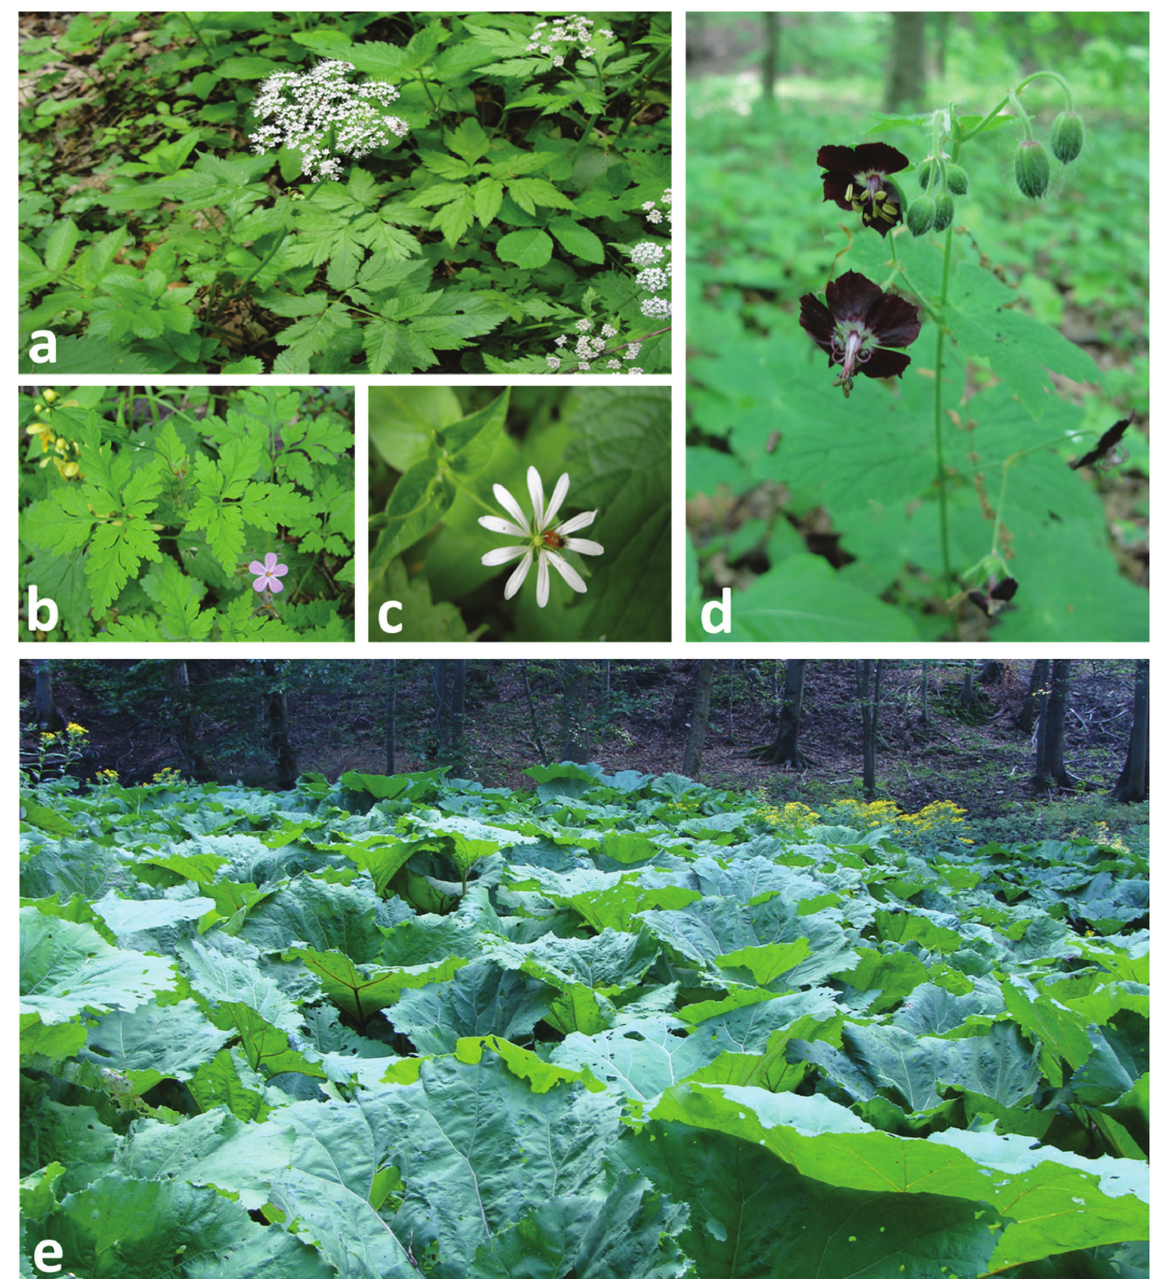
Figure 3. Tall-forb vegetation belonging to the Petasito-Chaerophylletalia . a–d. Geranio phaei-Urticetum dioicae com- ponents in colline location (330‒380 m a.s.l. in the Pełcznica river’s ravine (Wałbrzyskie Foothills, Central Sudetes) ( a. Chaerophyllum hirsutum ; b. Geranium robertianum ; c. Stellaria nemorum ; d. Geranium phaeum ); e. Petasitetum hybridi in the valley of the Bystrzyca Dusznicka river, 725 m a.s.l. (Bystrzyckie Mts., Central Sudetes). (Photographs a–d . K. Reczyńska; e. K.